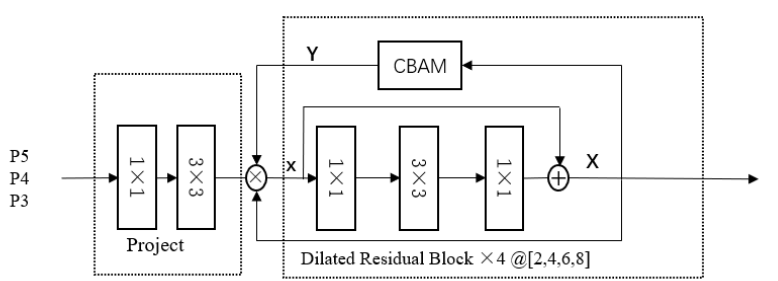
Figure 4. The sketch of Dilated Encoder Network. P3, P4, P5 are feature maps that form CSPDarknet in YOLOX_L.